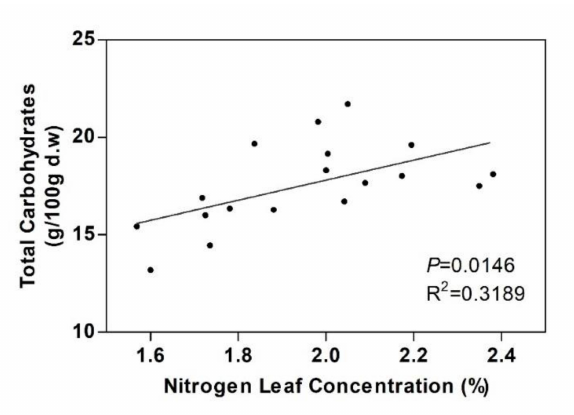
Figure 7. Correlation of leaf total sugars from structural carbohydrates with nitrogen leaf concentrations ( n =